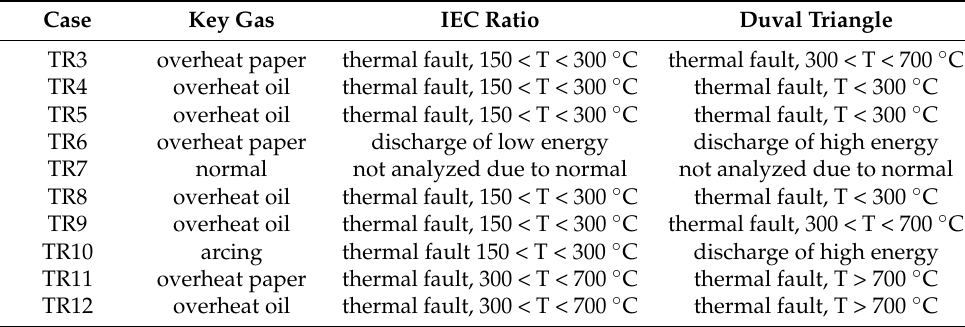
Table 15. Fault identification by key gas, IEC ratio, and Duval triangle